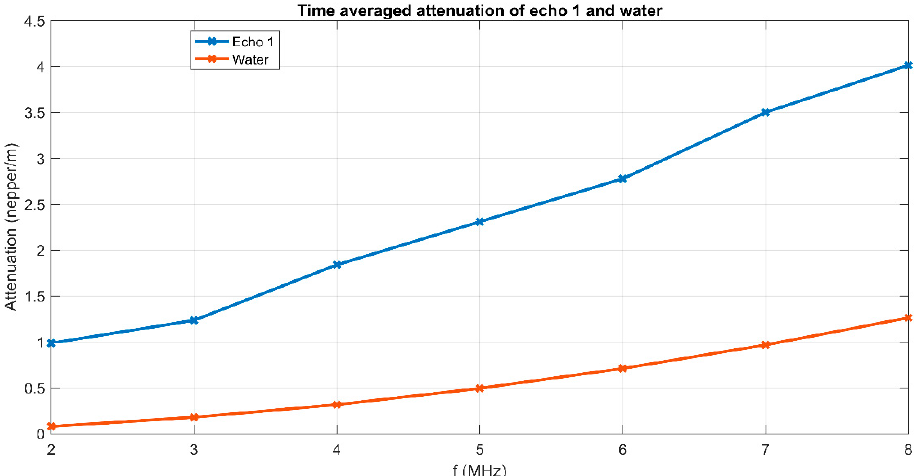
Figure 6. Attenuation vs. frequency for the first transmitted echo of the suspension (blue) and the reference fluid (red).